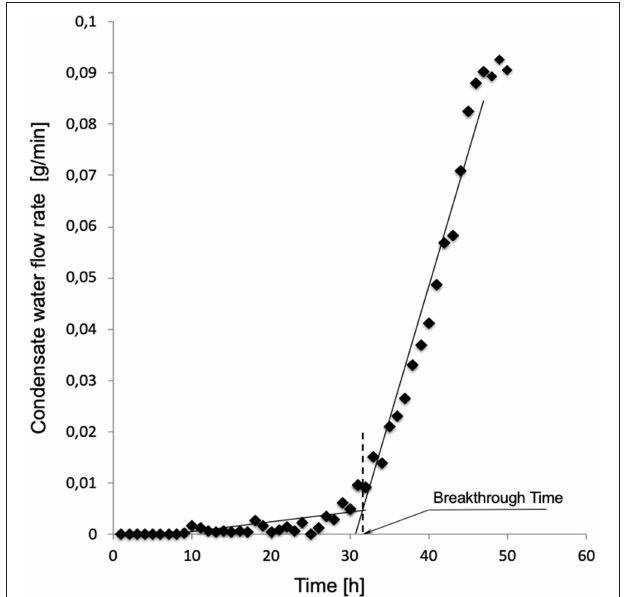
FIGURE 2 | Typical time variation of the water flow rate leaving the module through the gas side of modules equipped with membranes Type I. Experiment performed as described in Materials and Methods with solutions containing 3.1 g/L phosphatidylcholine.